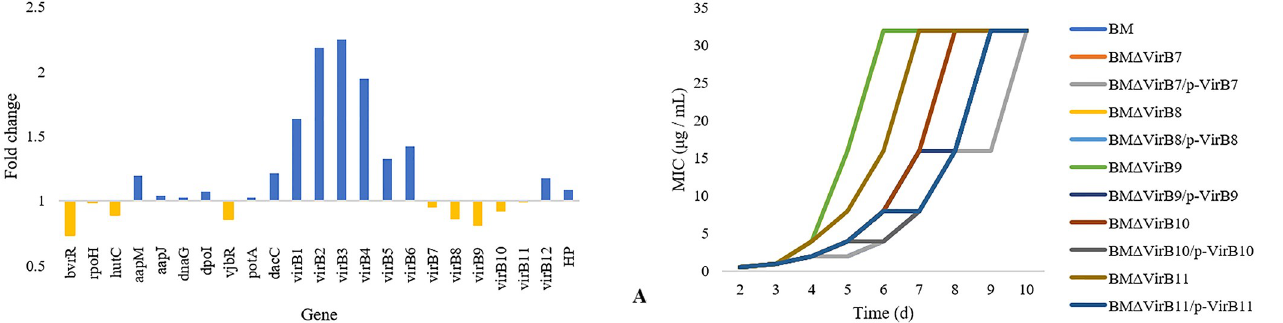
Fig 6. MIC values of rifampicin for the gene deletion and parent strains cultured for 10 d. (A) shows the expression levels of the VirB genes by RT-PCR, (B) shows the MIC values of the gene deletion and parent strains.